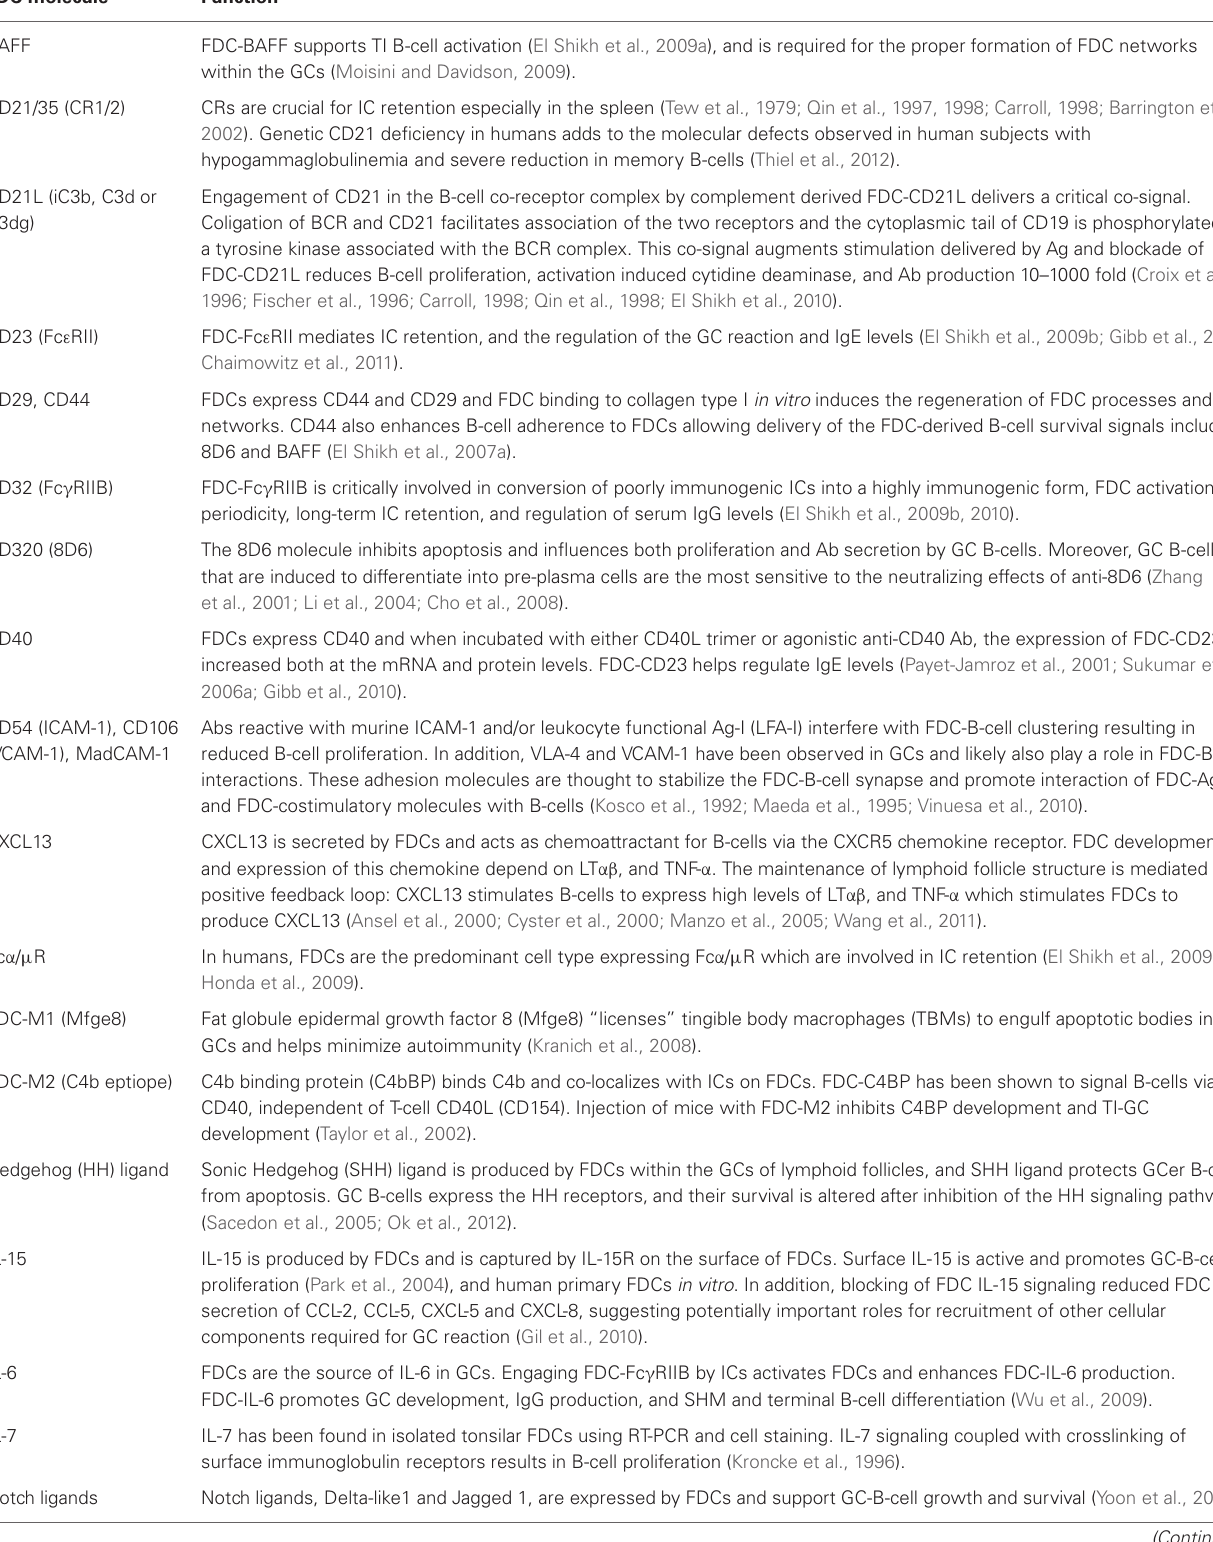
Table 1 | FDC regulatory and signaling molecules. FDC